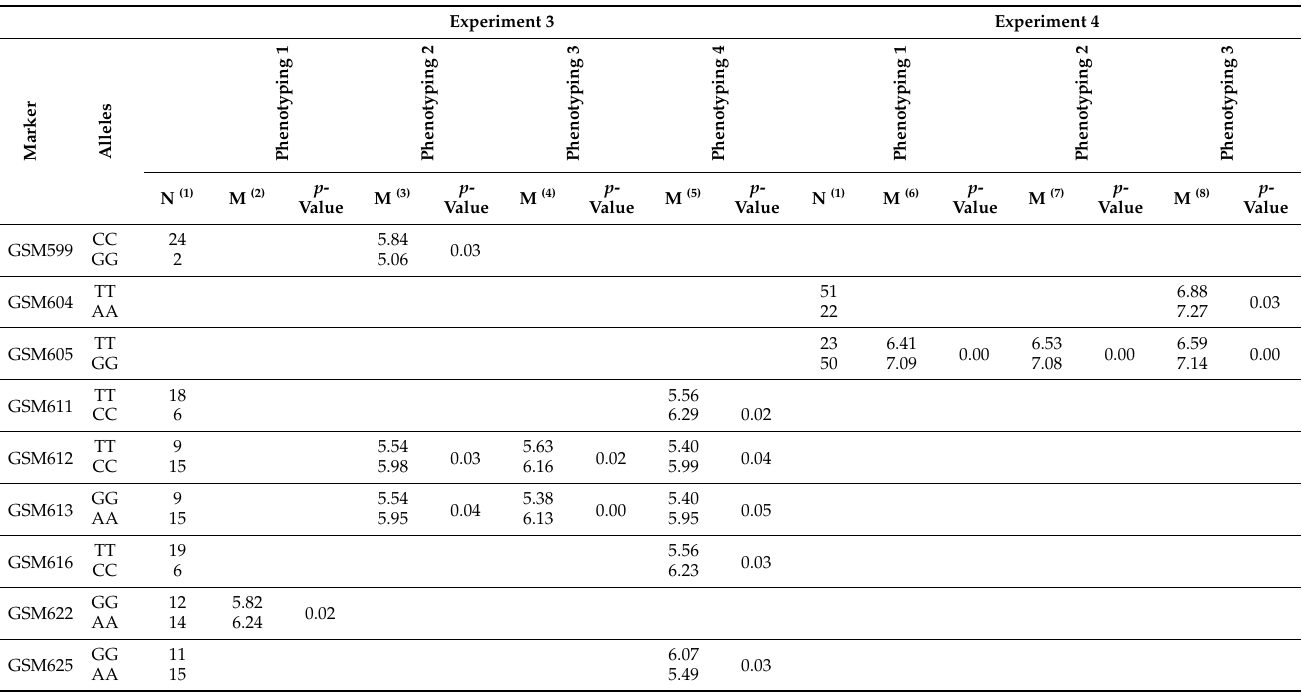
Table 6. Associative analysis of SNP markers for phenotyping (visual score) of Brazilian soybean genotypes under flooding conditions (Experiments 3 and 4). Experiment